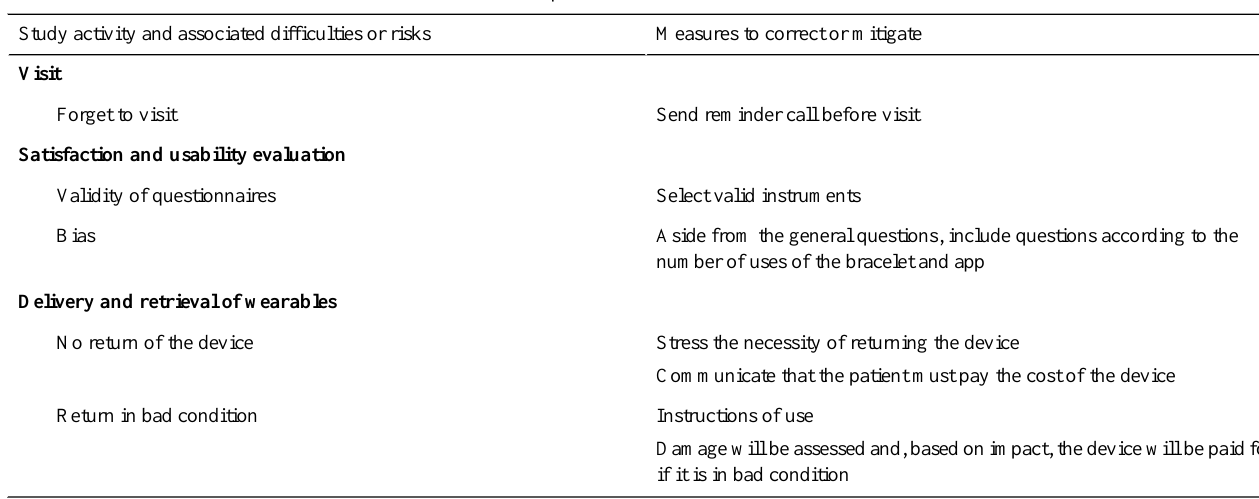
Table 5. Difficulties associated with activities of the second in-person visit and their correction measures.